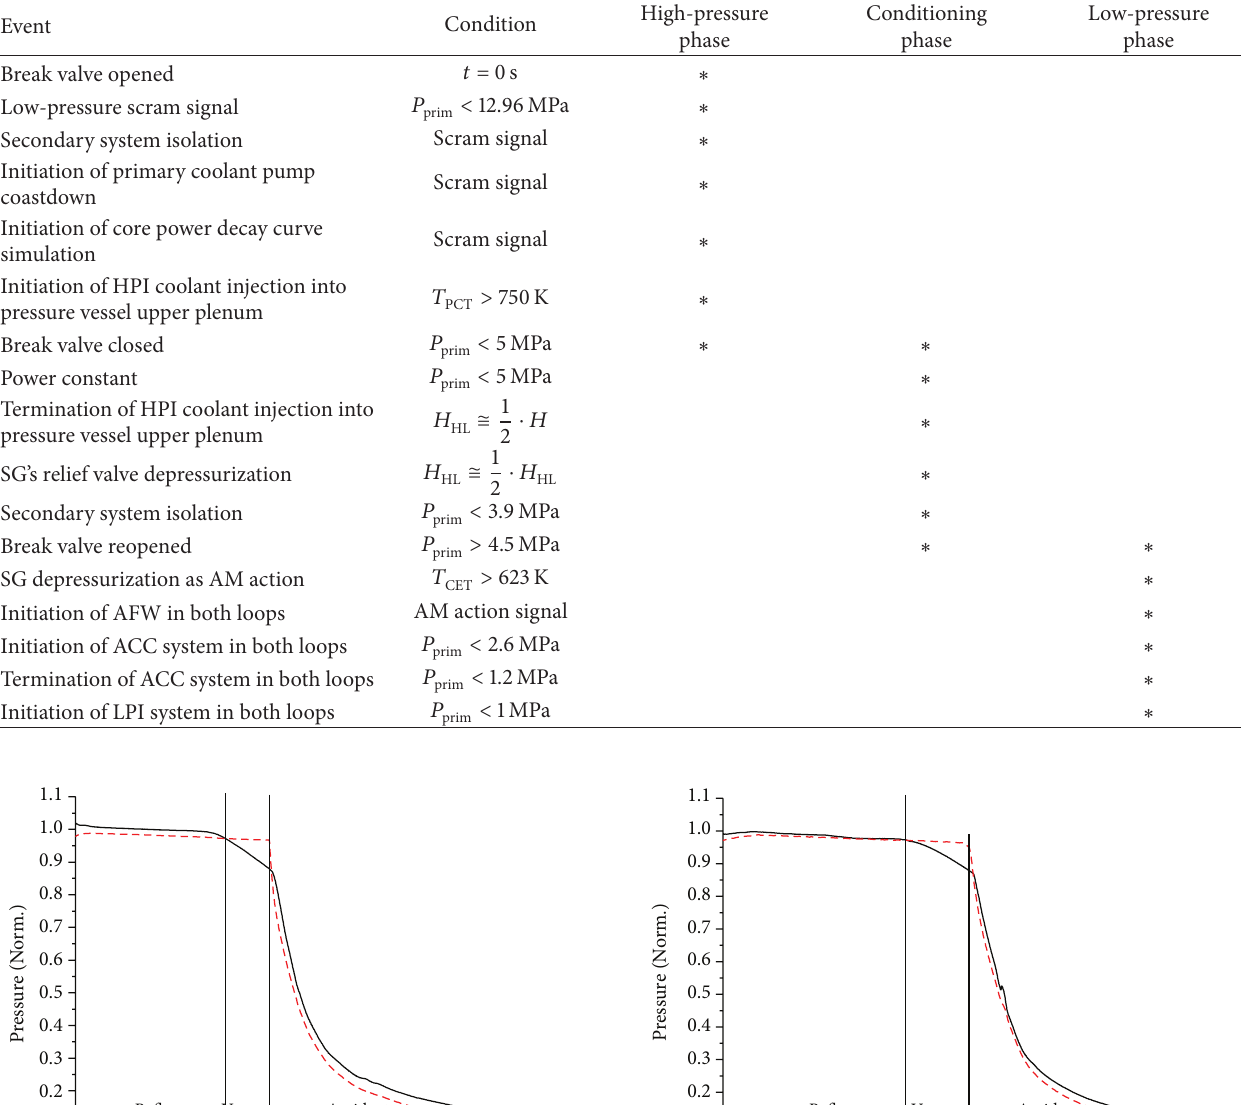
Table 2: Test 3 test conditions.